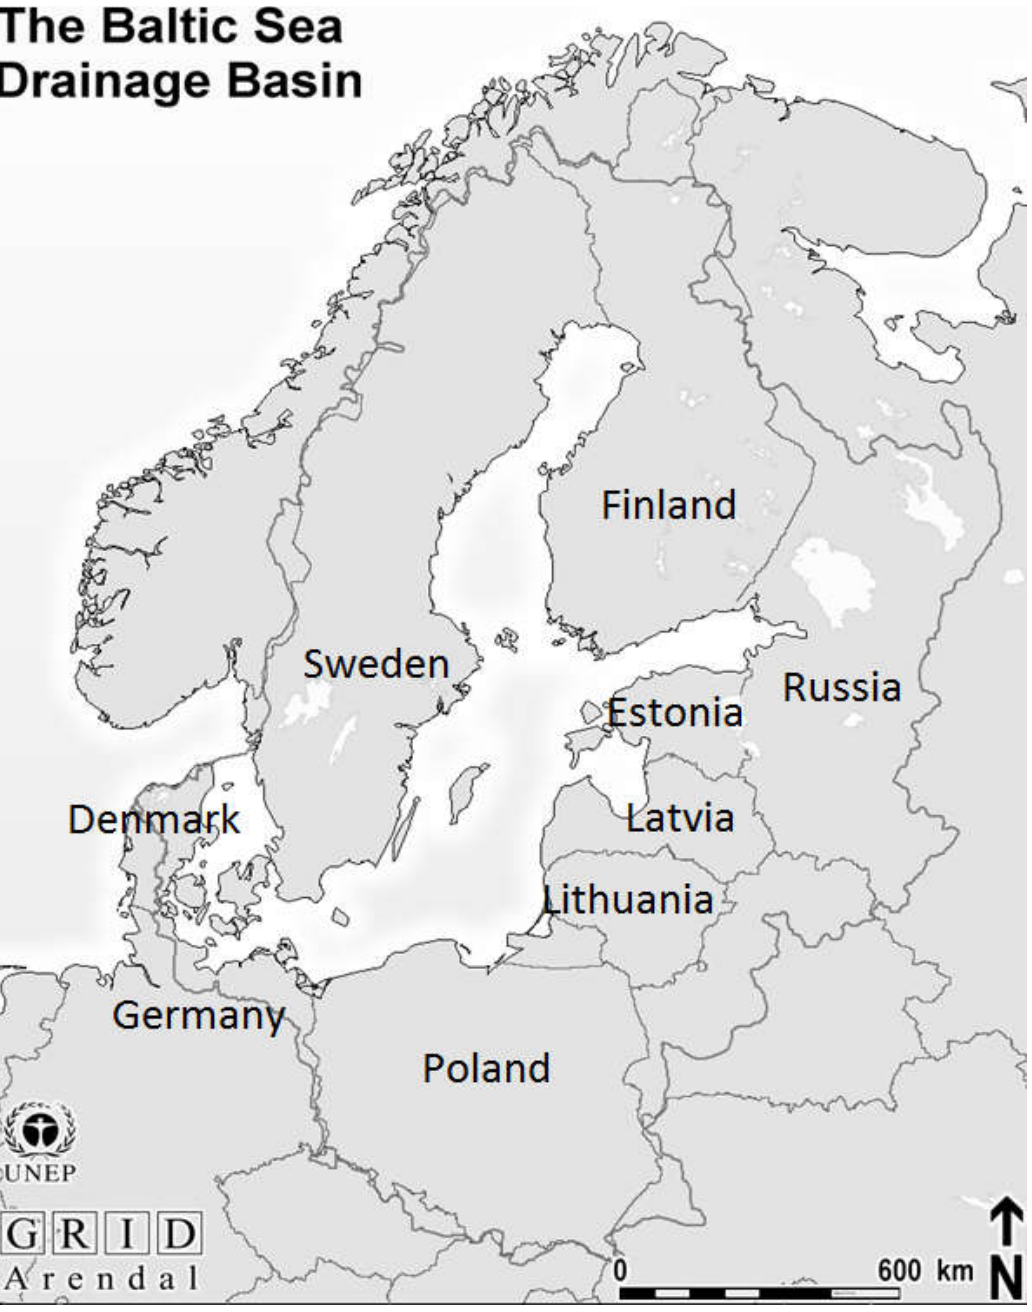
Figure A1. The Baltic Sea drainage basin. Source. GRID Arendal (http://www.grida.no/baltic/htmls/maps.htm).